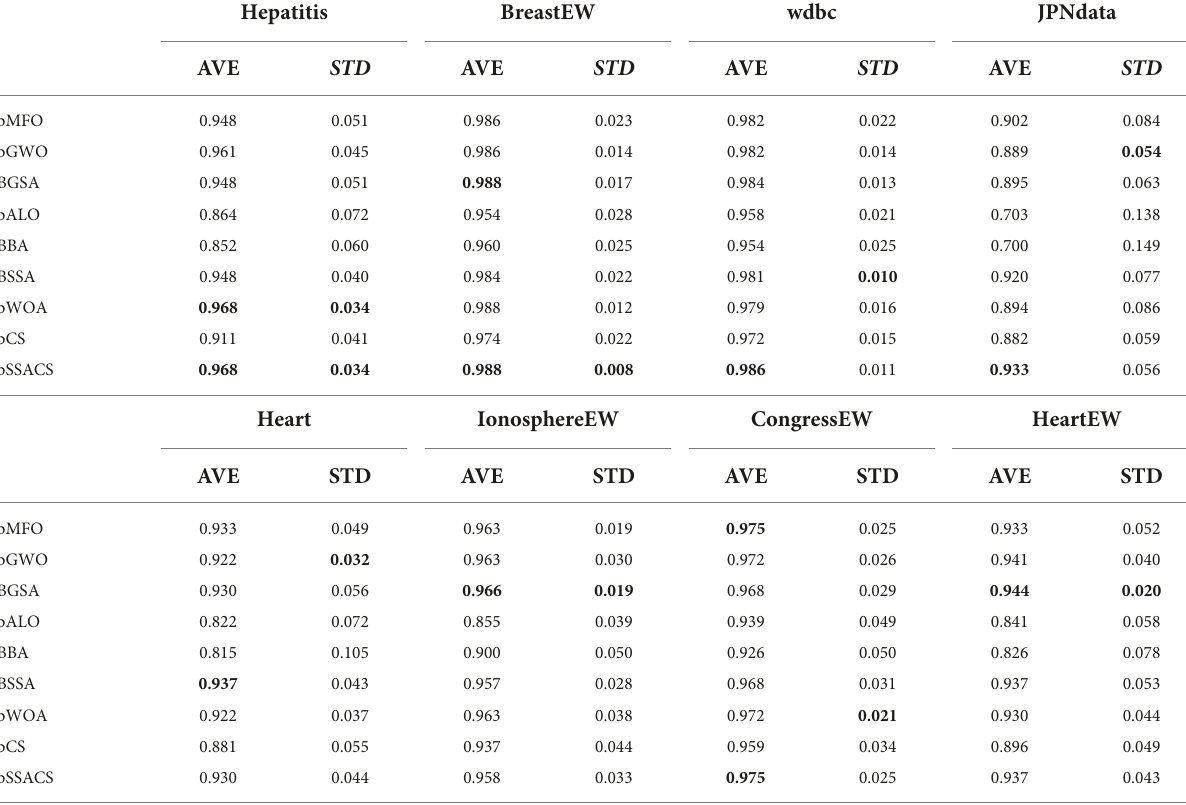
TABLE 9 Accuracy results of experiments on public datasets.